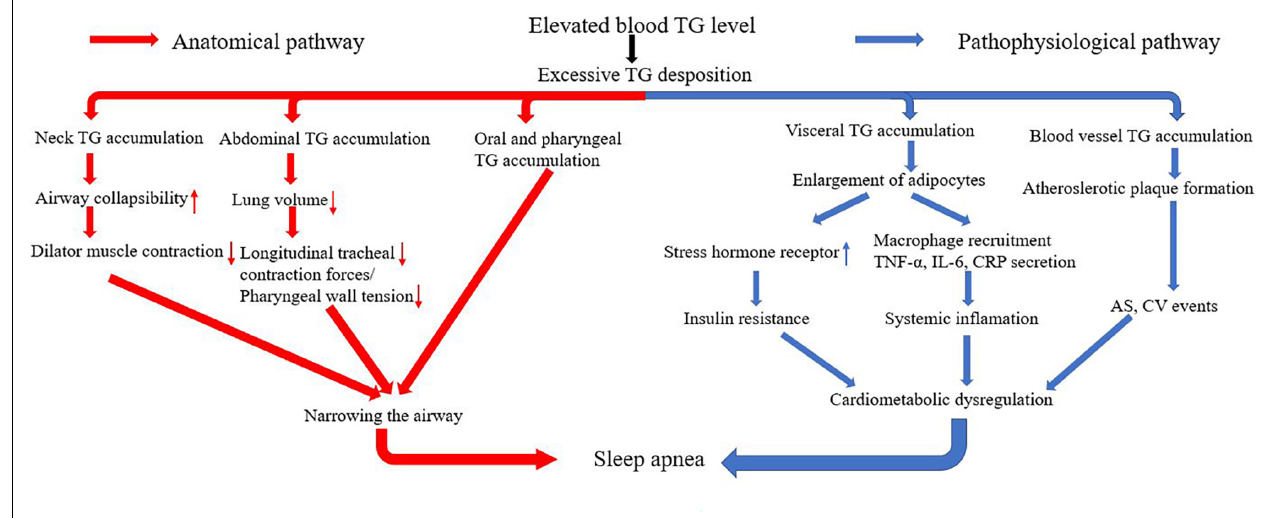
FIGURE 6 | Underlying mechanisms linking triglyceride with sleep